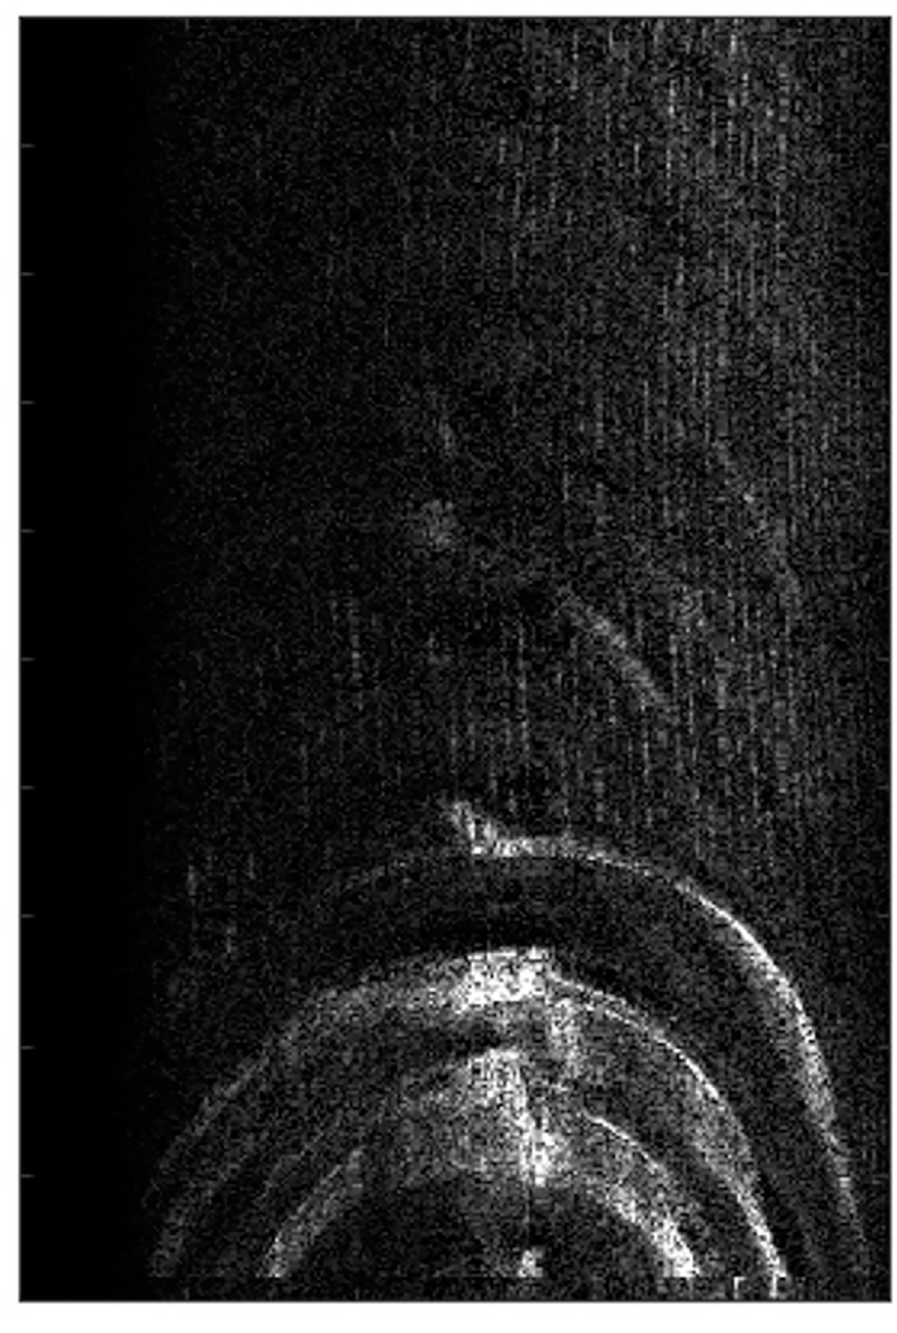
Fig 11. The real focused